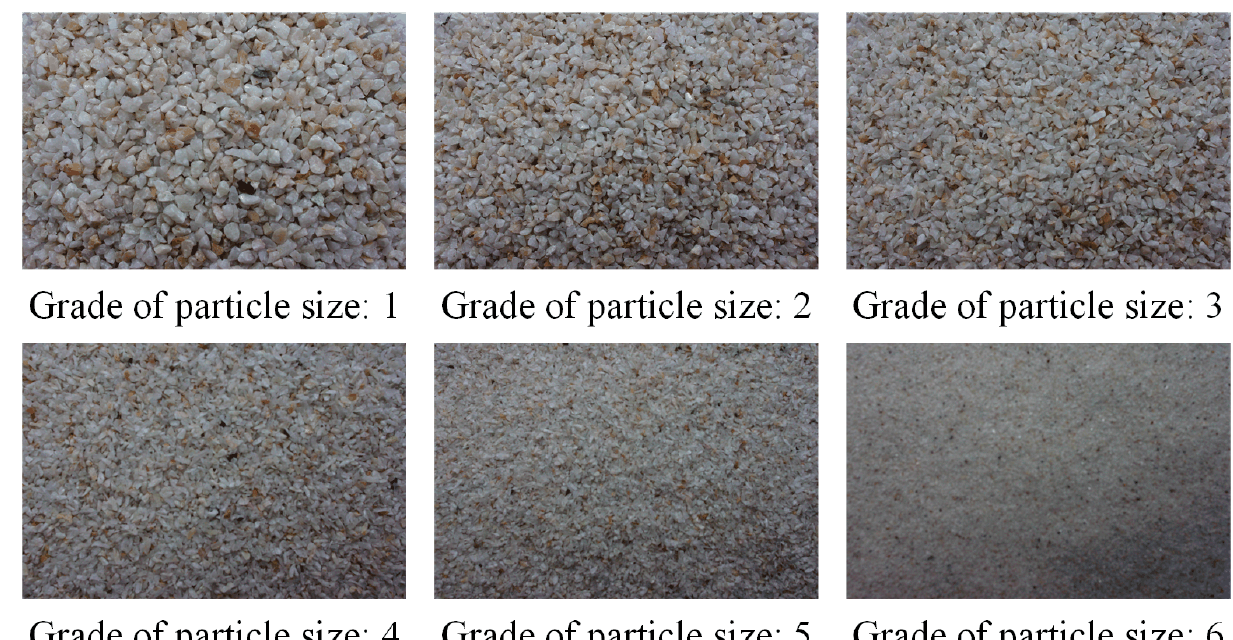
Figure 6. Particle size grade after abrasion.